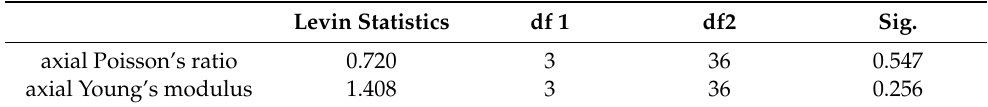
Table 2. The testing homogeneity of